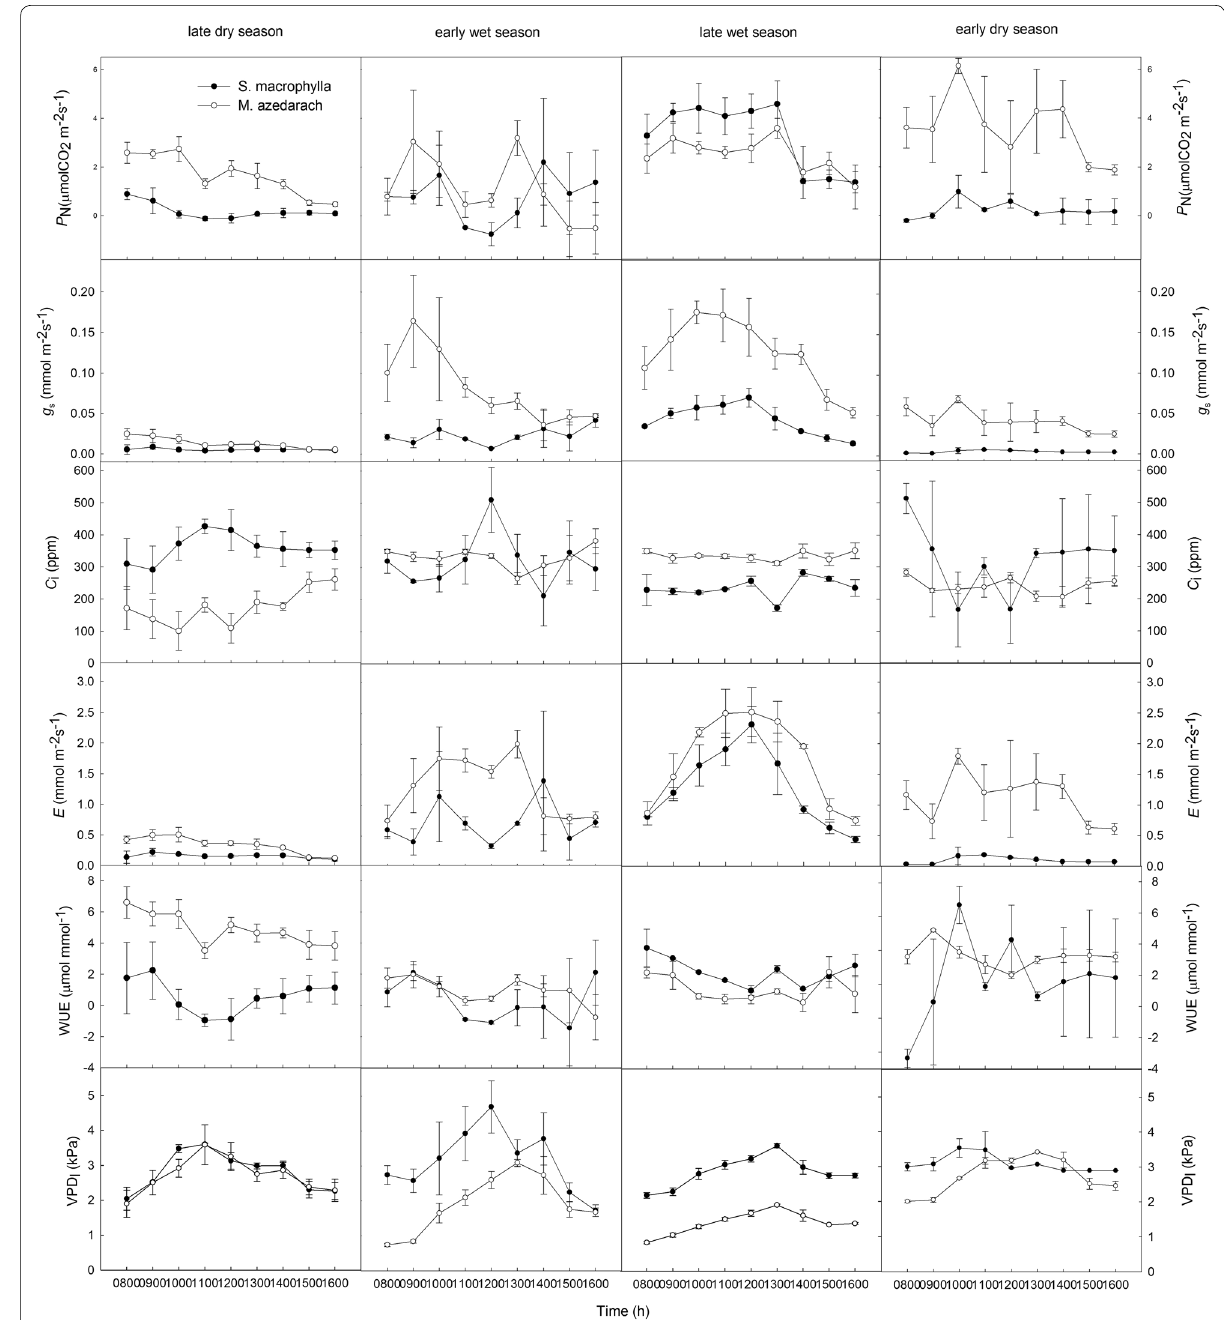
Fig. 3 Diurnal variation in gas exchange in Swietenia macrophylla and Melia azedarach in 2010. Net photosynthetic rate ( P N ), stomatal conductance ( g s ), intercellular CO 2 concentration ( C i ), water use efficiency (WUE), and leaf‑air vapor pressure deficit (VPD l ), late dry season (27 March), early wet season (26 June), late wet season (25 September), and early dry season (30 December). Data are represented as the mean